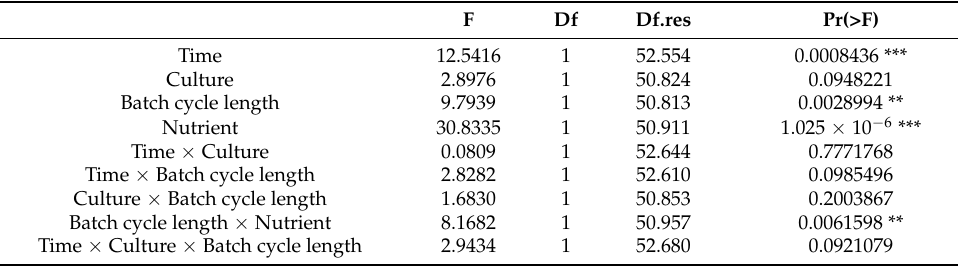
Table 7. Analysis of deviance table of Type II Wald F tests with Kenward-Roger df for linear mixed- effects model using the proportion of C. affinis genotype B57 as response variable. Stars show significance level of the test; *** p < 0.001 and ** p < 0.01. F Df